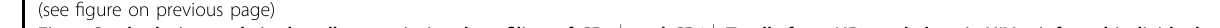
Fig. 1 Study design and single-cell transcriptional pro fi ling of CD4 + and CD8 + T cells from HDs and chronic HIV-1-infected individuals. a Schematic showing the overall study design. scRNA-seq was applied to CD4 + and CD8 + T cells across the three conditions, and the output data were used for TCR pro fi ling and expression analyses. b Cellular populations identi fi ed for CD4 + T cells. The t -SNE projection of 79,405 single cells from HD ( n = 4), TP ( n = 9), and ART ( n = 8) samples, showing the formation of 13 clusters with the respective labels. Each dot corresponds to a single cell, colored according to cell types. c Violin plots showing the expression distribution of selected canonical cell markers in the 13 clusters of CD4 + T cells. Row representing selected marker genes and column representing clusters with the same color in b . d Cellular populations identi fi ed for CD8 + T cells. The t -SNE projection of 89,155 single cells from HD ( n = 4), TP ( n = 9), and ART ( n = 8) samples, showing the formation of 11 clusters with the respective labels. Each dot corresponds to a single cell, colored according to cell types. e Violin plots showing the expression distribution of selected canonical cell markers in the 11 clusters of CD8 + T cells. Row representing selected marker genes and column representing clusters with the same color in d